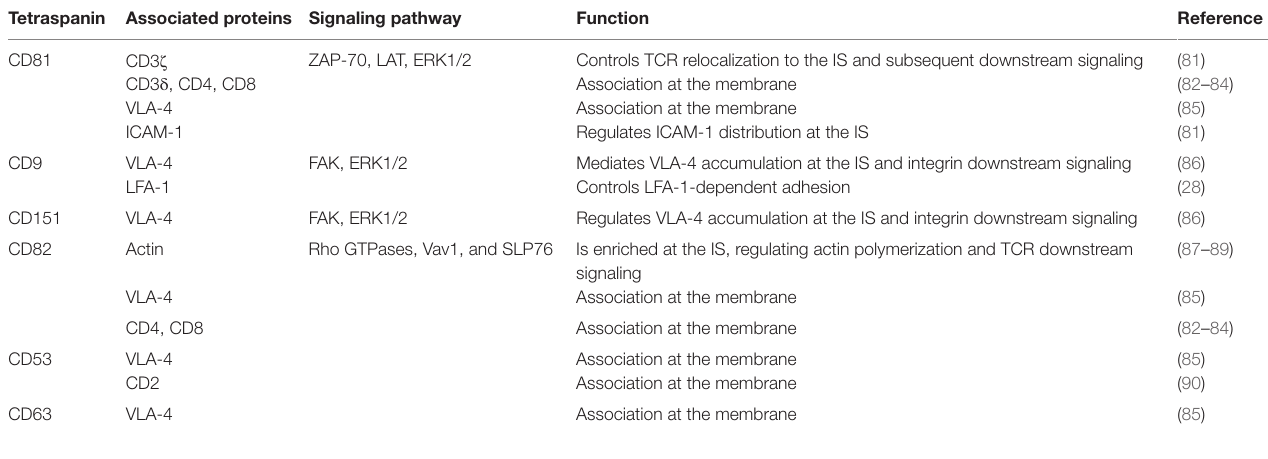
TABLe 2 | Tetraspanin associations in T cells and their role at the immunological synapse. Tetraspanin Associated proteins Signaling